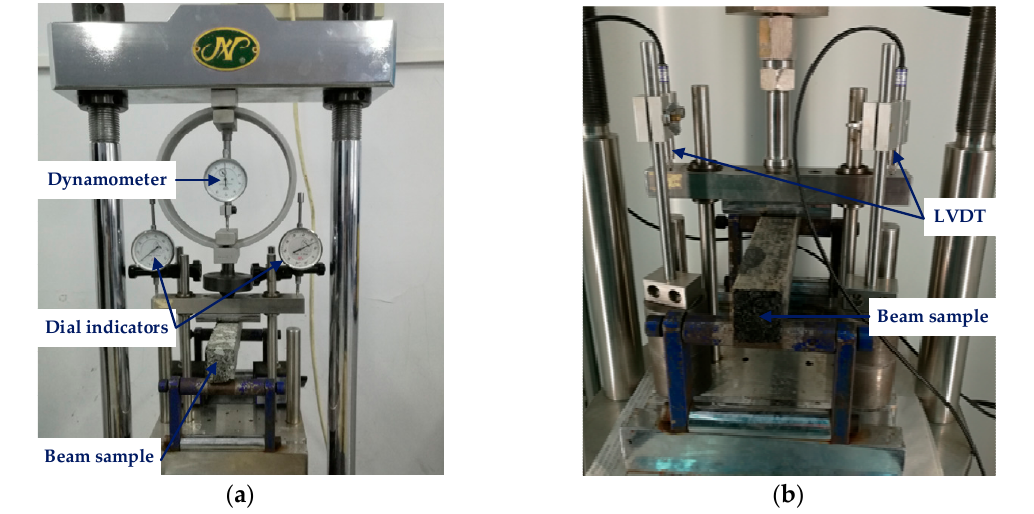
Figure 3. Low ‐ temperature viscoelastic property tests: ( a ) Beam bending failure test; and, ( b ) Beam bending creep test.